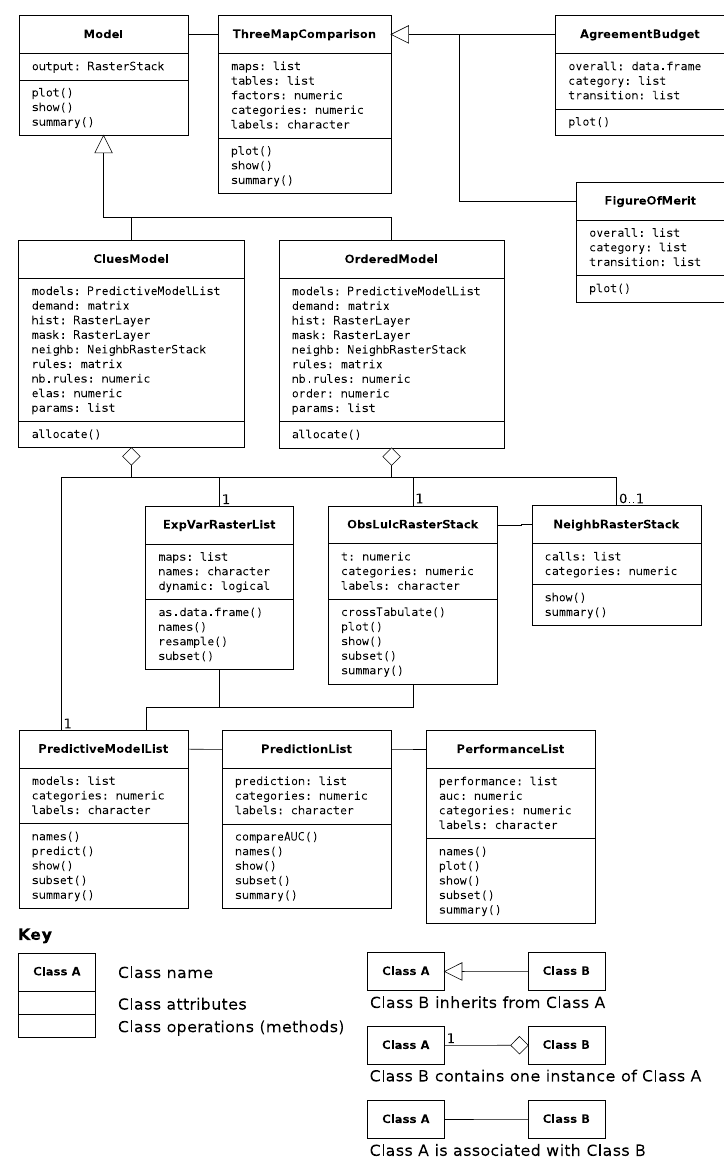
Figure 2. Class diagram in the Unified Modeling Language (UML) for lulcc, showing the main classes and methods included in the